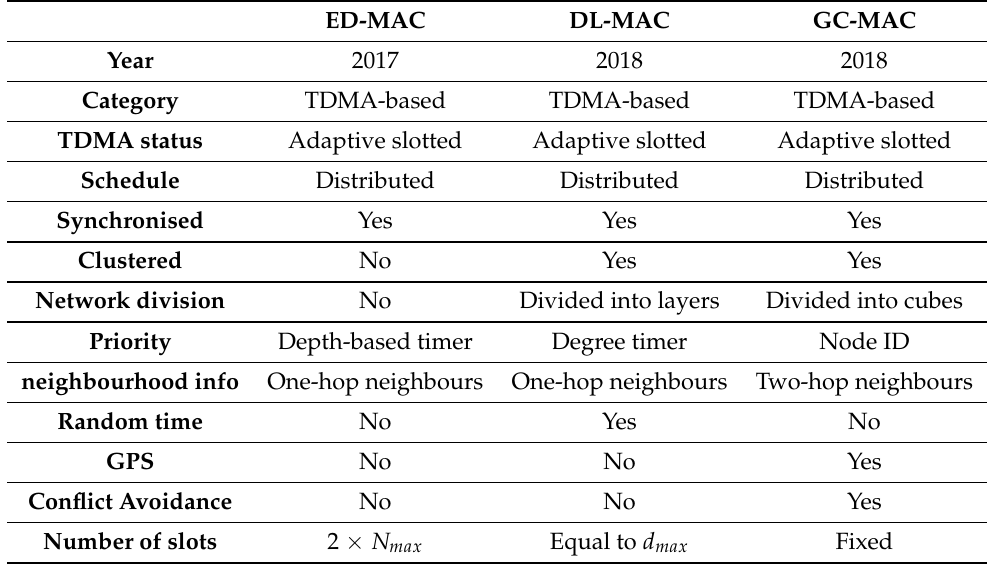
Table 1. Comparisons of TDMA-based distributed collision-free MAC protocols for